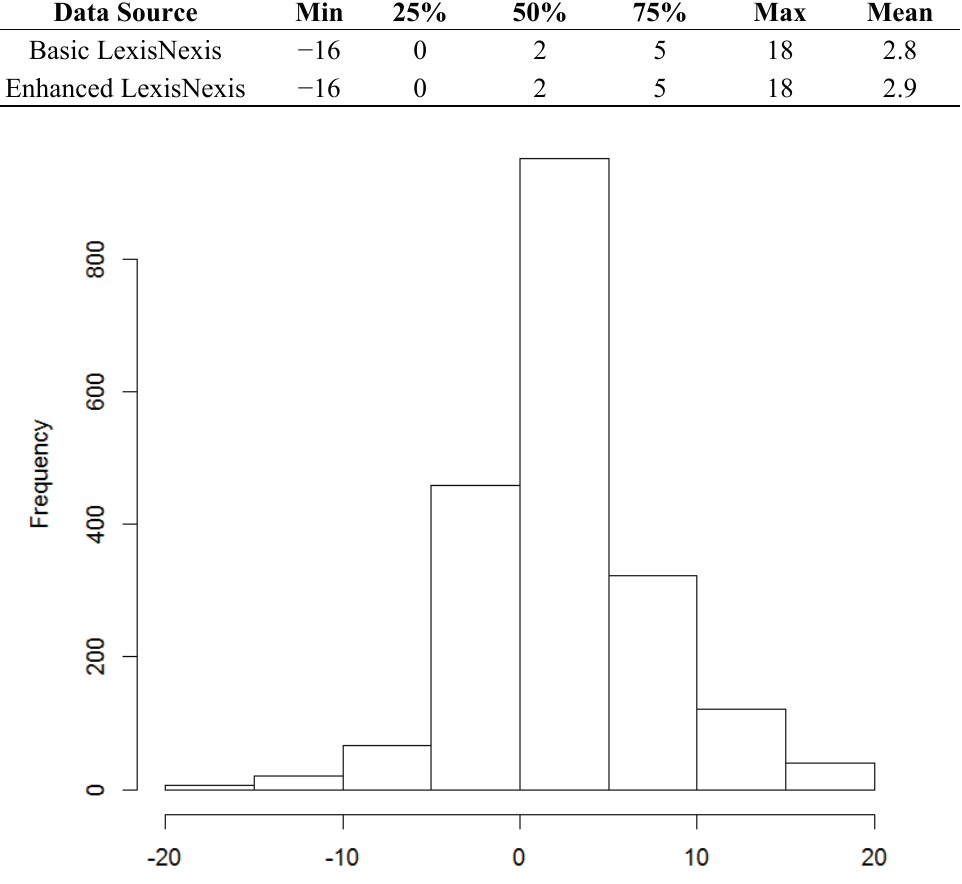
Figure 2. Distribution of the differences in time spent in years at each detailed matched